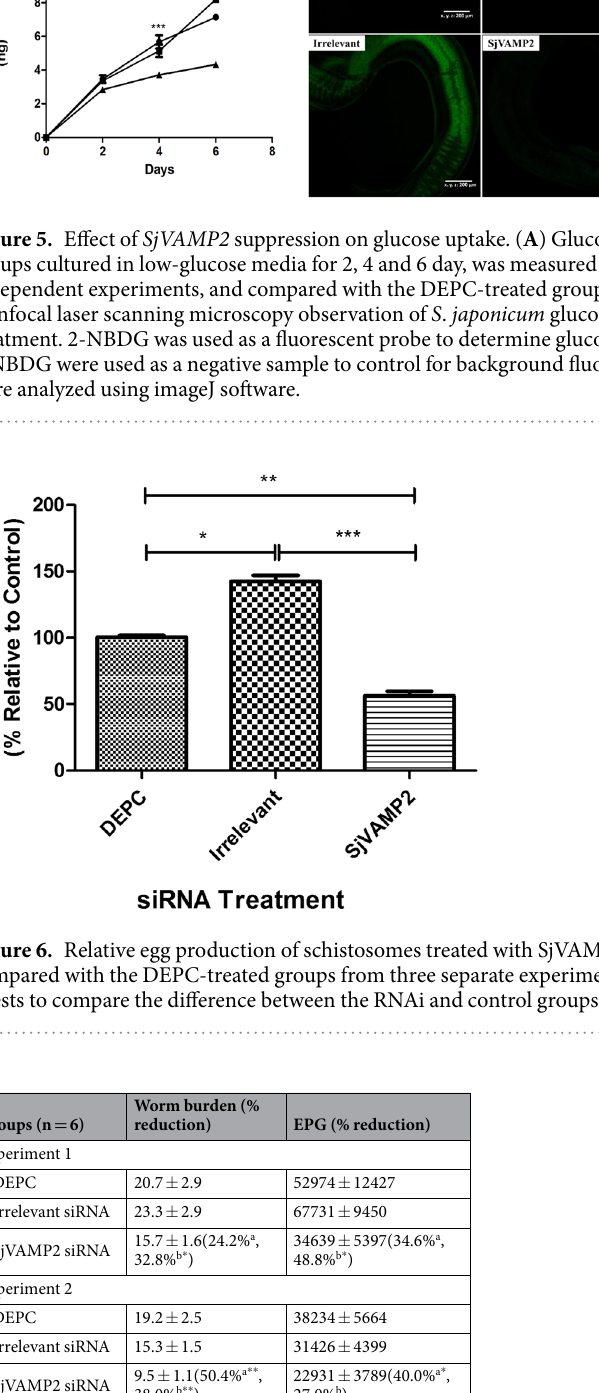
Table 1. Effects of SjVAMP2 gene silencing on worm burden and eggs laying. Data are presented as the mean ± standard error. * P < 0.05, ** < 0.01. a Compared with DEPC group. b Compared with Irrelevant siRNA group. EPG, eggs per gram (EPG) in livers recovered from